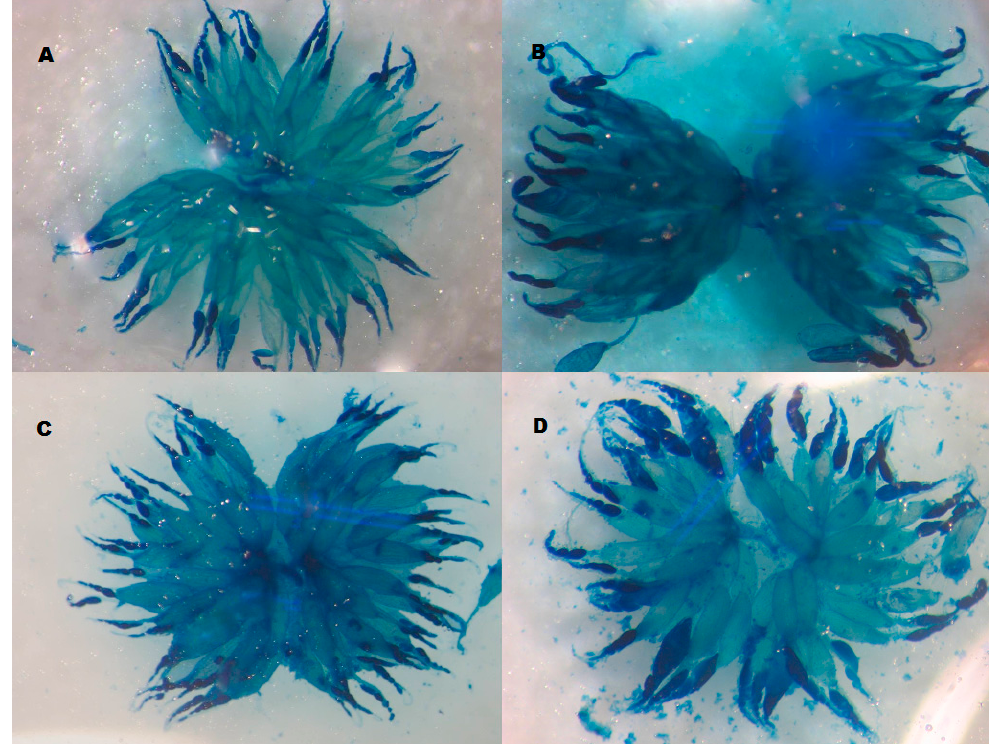
Figure 2. Ovaries stained with methylene blue. ( A , B ) D. buzzatii females reared in O. sulphurea and T. terscheckii , respectively and ( C , D ) D. koepferae females reared in O. sulphurea and T. terscheckii, respectively .